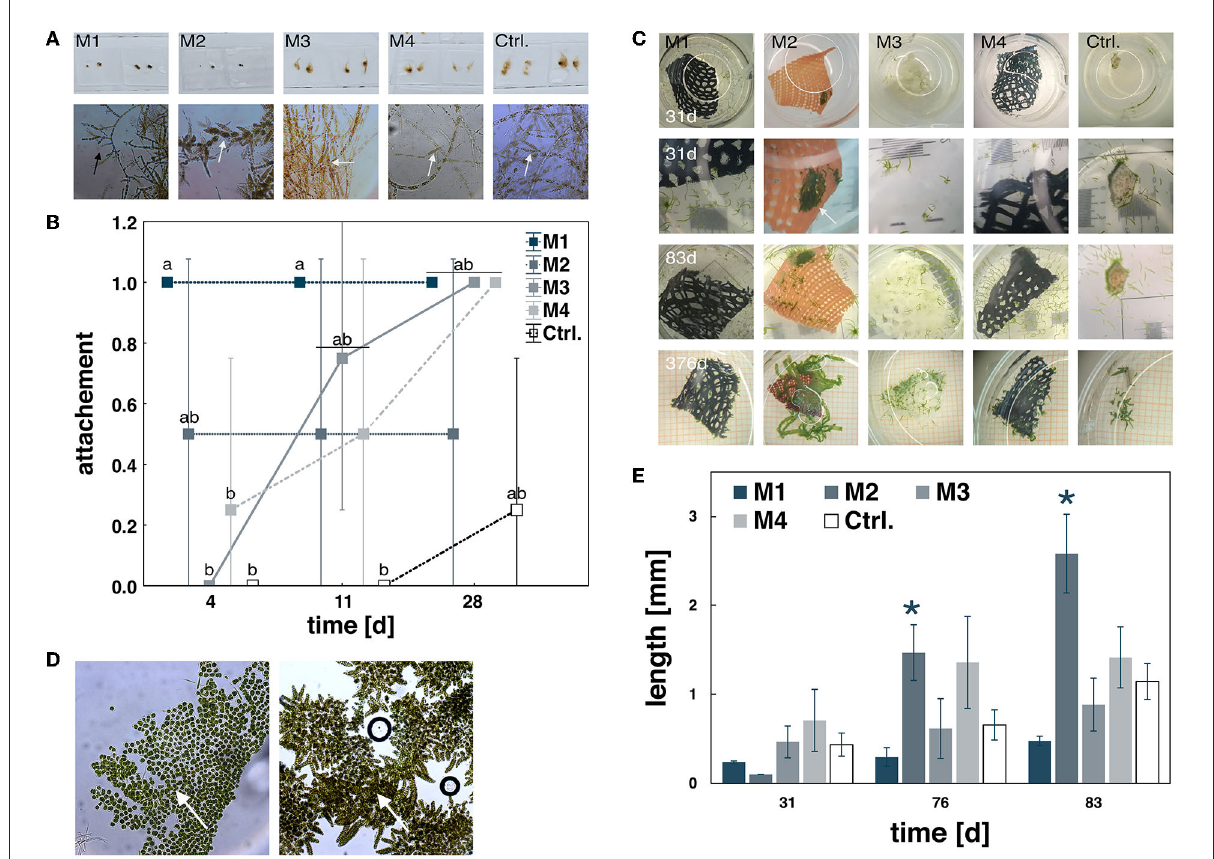
FIGURE2 Material tests with the brown alga Ectocarpus sp. and Ulva fenestrata . Thalli of Ectocarpus sp. after 28 days of exposure showing upright and creeping growth (black arrow) and fertile sporangia (marked by white arrows) (A) and differences in biofouling measured by % thallus attachment over 28 days (B) . Data are expressed as mean ± SD; significant differences ( p < 0.001) are indicated by lower case letters. The green alga Ulva fenestrata showing differences in germling development over time (C) , observed as crustose (left, arrow) and normal erect growth (right, arrow) at 31 days of exposure (D) , and differences at further increased lengths growth after 31 days (E) . Data expressed as mean ± SD; significant differences ( p < 0.001) are indicated by